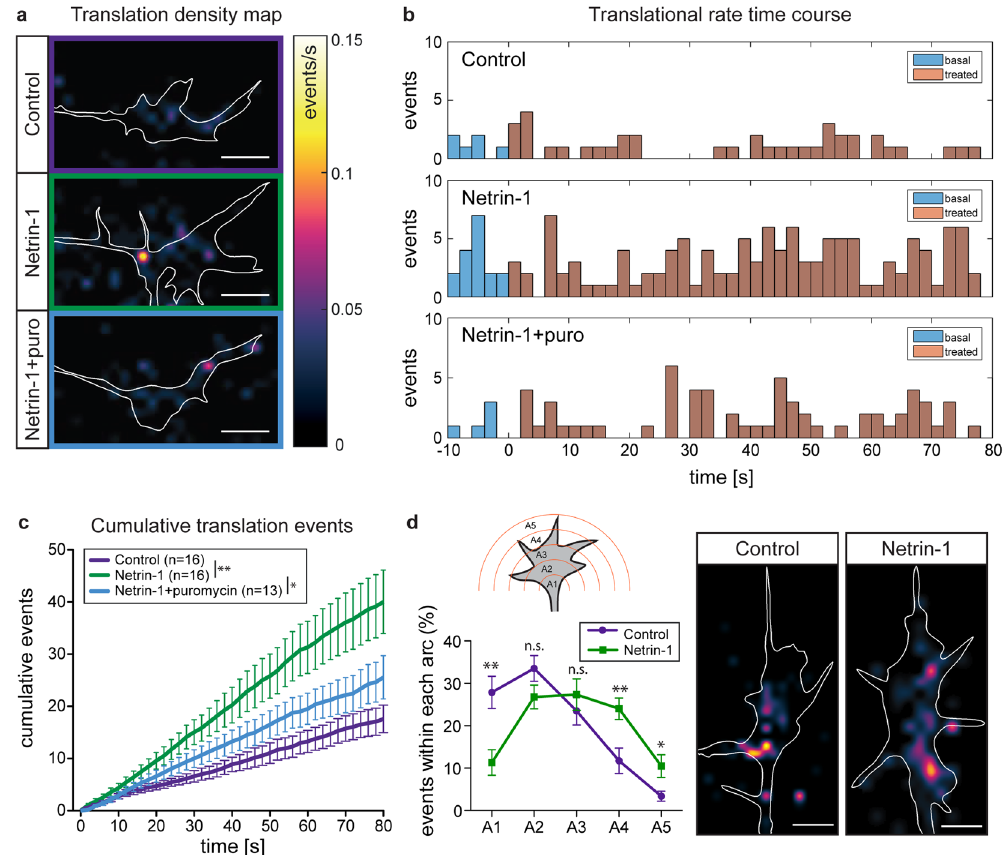
Figure 2. Netrin-1 increases β -actin translation rate. ( a ) Translation density maps for RGC growth cones treated with culture medium, Netrin-1, or Netrin-1 with puromycin pre-incubation. ( b ) Respective translation rate time courses of examples shown in a . The apparent difference in the pre-treatment rate between the culture medium- and Netrin-1-treated growth cones can be attributed to biological variability; the average pre-treatment rates between the two groups (n = 16) did not show any significant difference (p = 0.63). ( c ) Cumulative event rates per growth cone * p < 0.05; ** p < 0.001; two-way ANOVA. ( d ) Sholl analysis on culture medium- or Netrin-1-treated growth cone density maps revealing the spatial distributions of translational events. The center of 5 concentric circles is located at the base of the growth cone, with the outermost circle intersecting the furthest boundary of the growth cone. The radii are equidistant. A1 denotes the most central arc, while A5 indicates the most peripheral arc. Intracellular events within each arc are counted and the percentages within each arc are shown in the graph. ** p < 0.001; Mann-Whitney Houston test; scale bars are 5 μ m. Error bars indicate standard error of the mean. In c , n is the number of growth